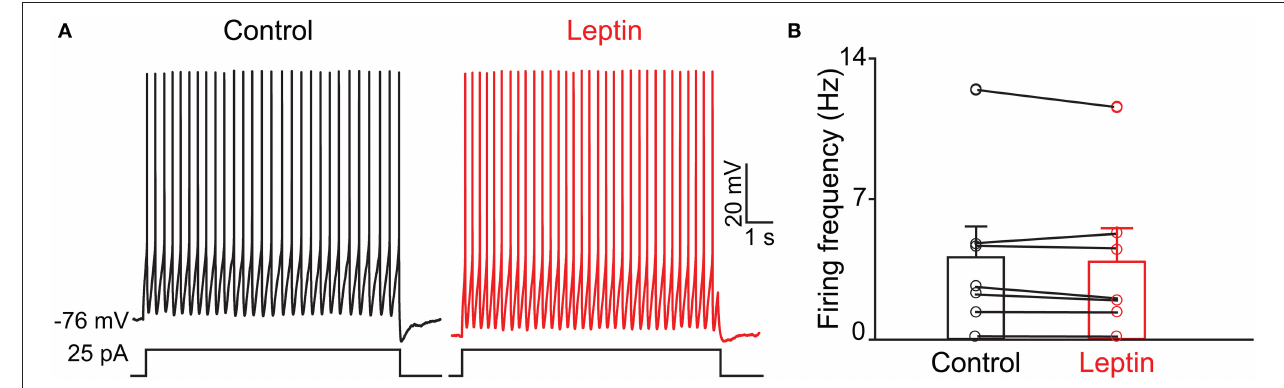
FIGURE 6 | The activity of PPG neurons is not modulation by leptin. (A) Representative current-clamp recording and (B) bar/scatter plot of the mean AP firing frequency as in Figure 4 , but for leptin, n = 7, not significantly different from baseline, paired t -test, p > 0.05.